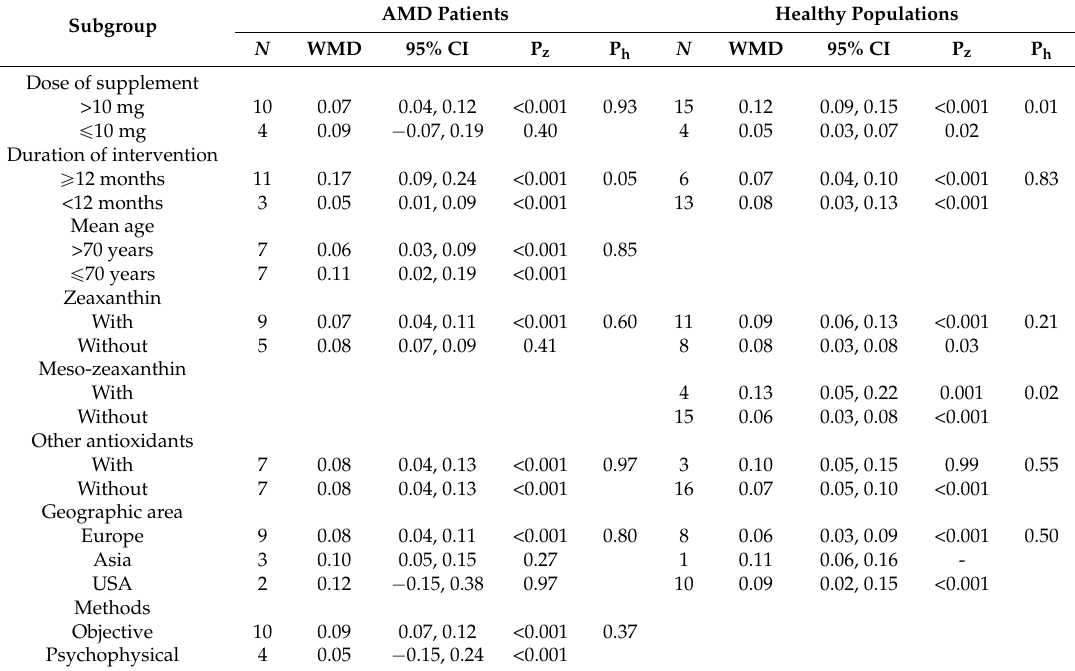
Figure 1. Forest plot showing the efficacy of lutein, zeaxanthin and meso-zeaxanthin supplementation on macular pigment optical density for patients with AMD and healthy subjects. Error bars indicate 95% CIs of the WMDs. The sizes of the squares correspond to the study weight in the random-effects meta-analysis. Diamonds represent the meta-analysis summary effect estimate. AMD, age-related macular degeneration; CI, confidence interval; WMD, weighted mean differences. Table 2. Stratified analysis for the lutein or/and zeaxanthin or/and meso-zeaxanthin supplements effect on macular pigment optical density (MPOD) across the assessed randomized controlled trials (RCTs).